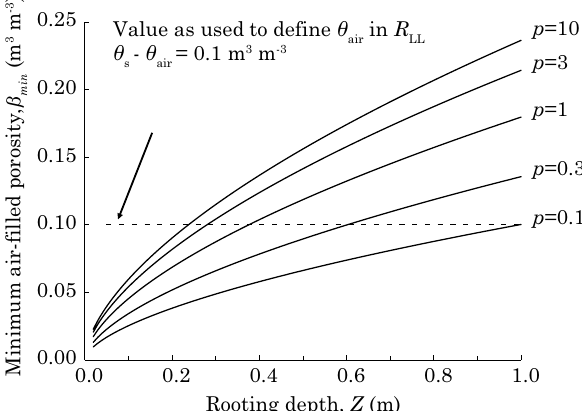
Figure 5. Minimum air-filled porosity for proper aeration β min as a function of the empirical parameter p and depth of the root system Z , as calculated by equation